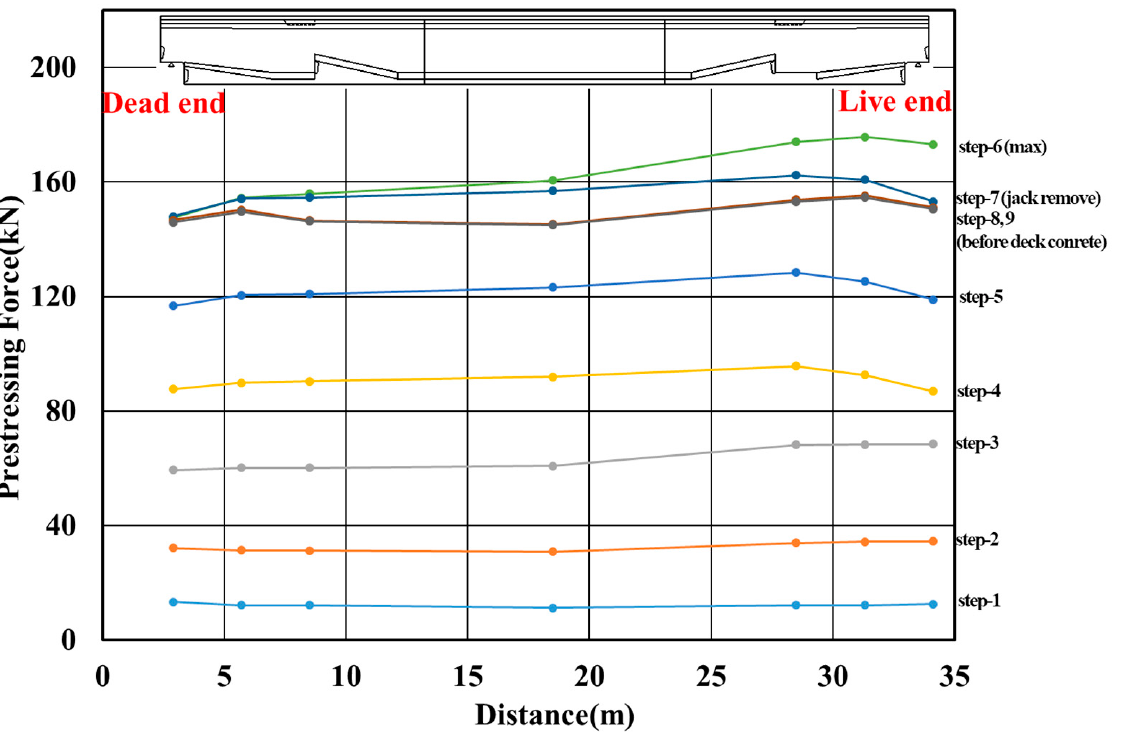
Figure 8. Variation of prestress force in tendon one of full-scale BH girder bridge prototype per tensioning step measured by OSPC strand.